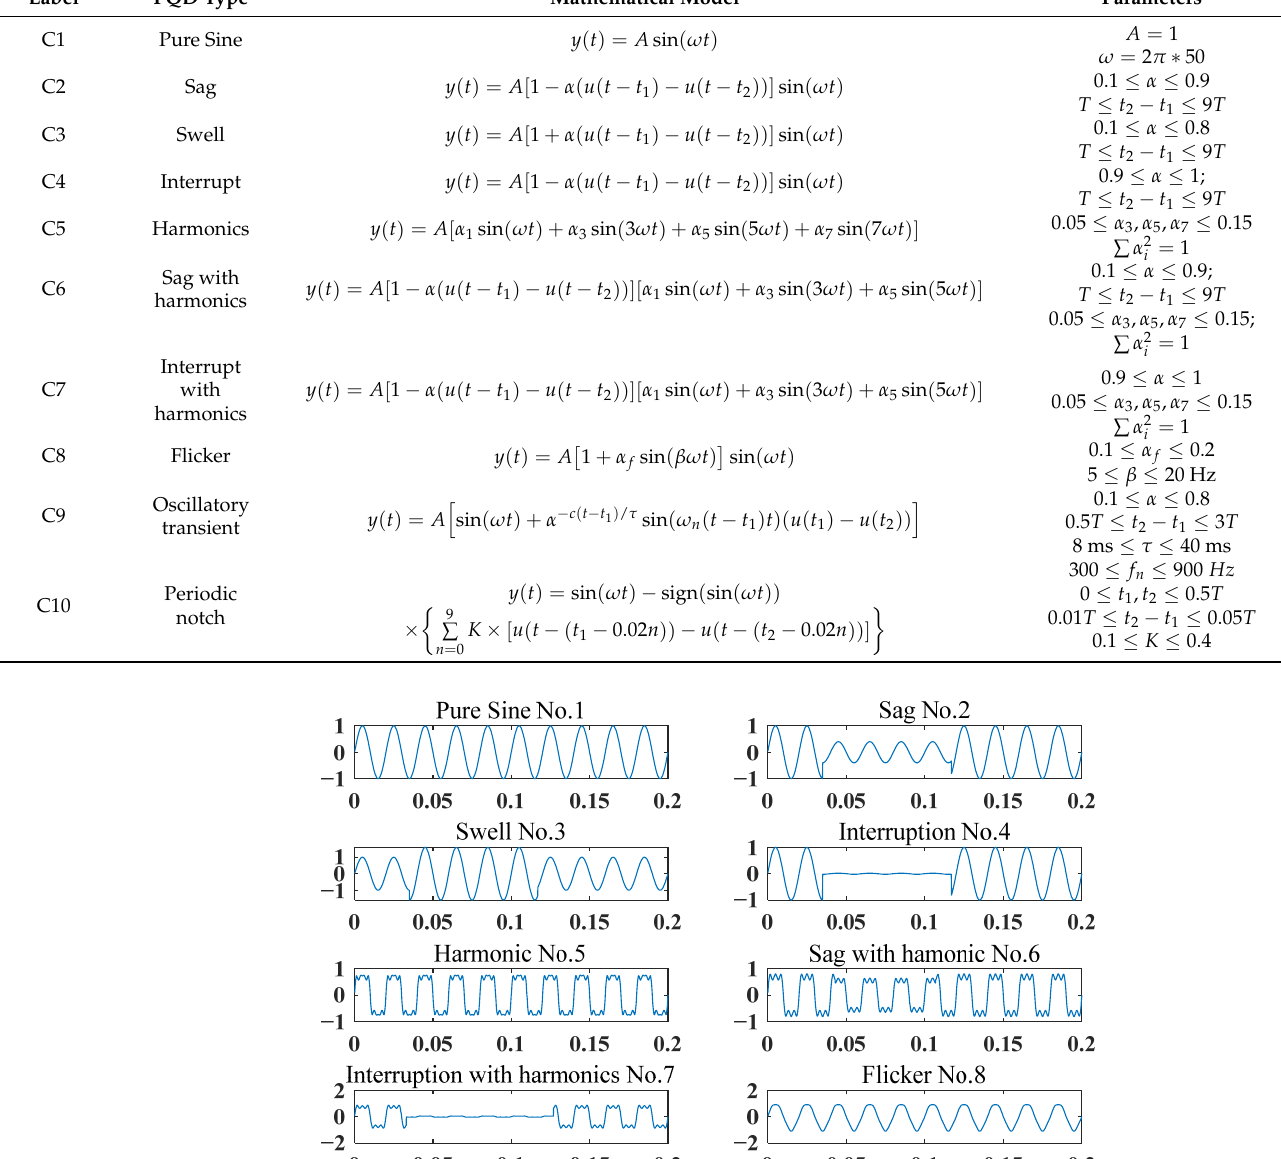
Table 1. PQD mathematical model [27].